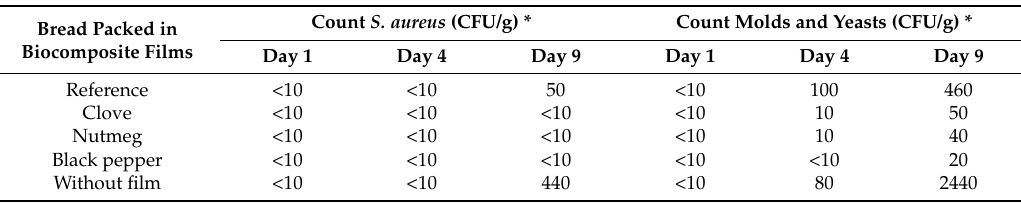
Table 3. Microbiological analysis of the bread packaged in biocomposite films and stored during nine days at 25 ◦ C and 75%